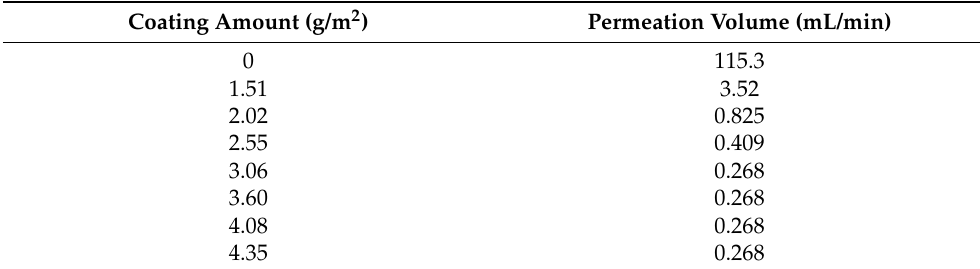
Table 5. Effect of coating amounts on air permeability of packaging base